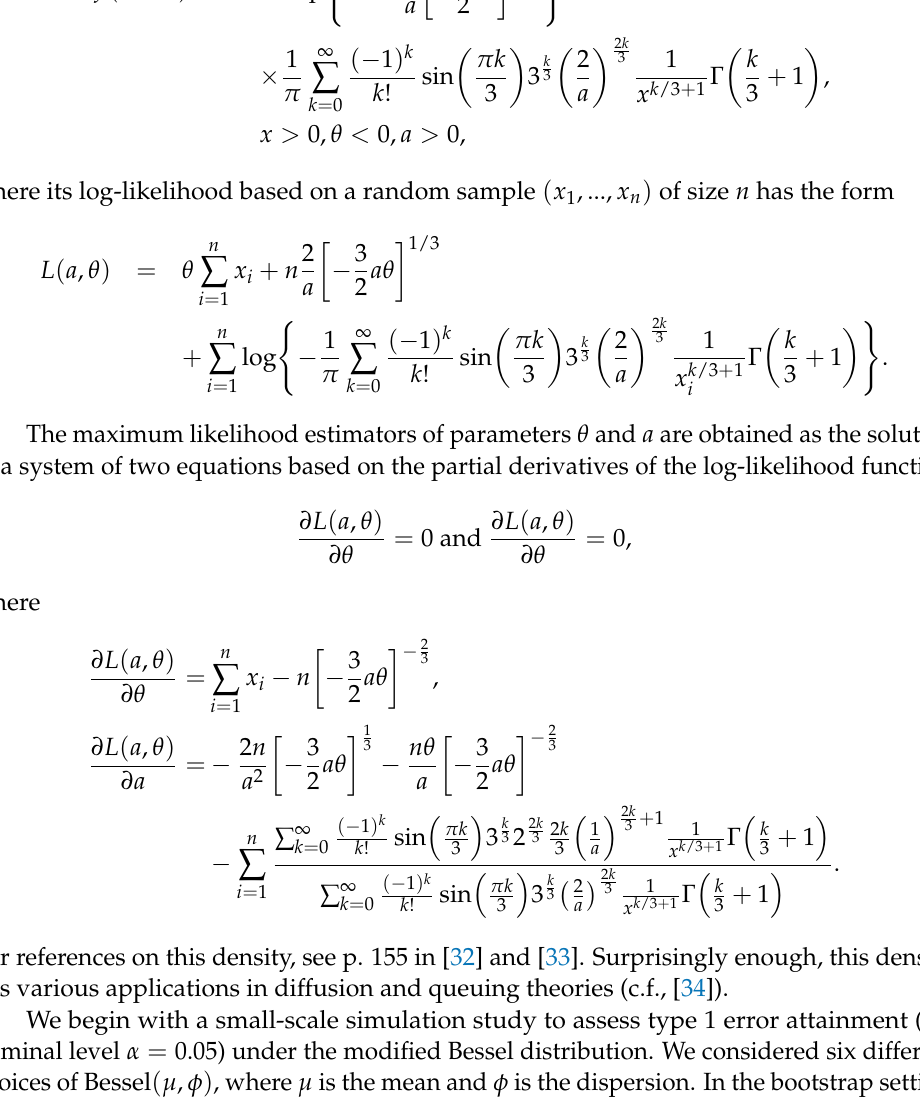
Table 3. Percentage of 10,000 Monte Carlo samples declared to be significant by various tests for the modified Bessel distribution Bessel ( µ , φ ) . MLE ˆ ν was used, and α = 0.05. Asym Btstr Alternative n = 20 n = 50 Bessel ( 1,1 )